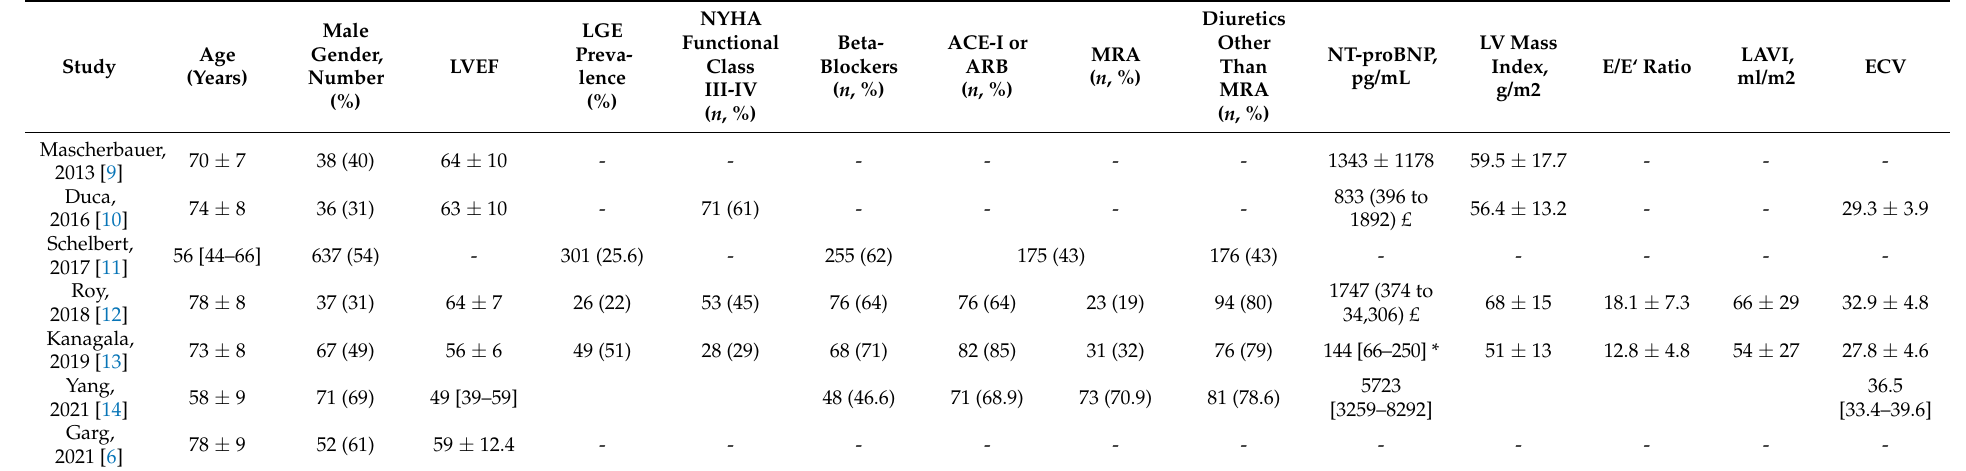
Table 2. Patient traits in the included